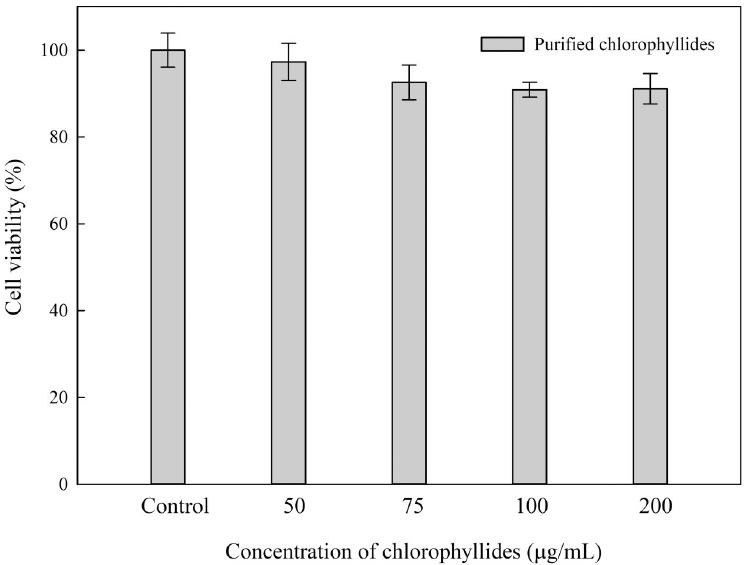
Fig 3. MTT assay of chlorophyllides in NIH/3T3 cells. The results showed that when the concentration was 200 μ g/ mL, there is no statistical difference between the control group (chlorophyllides absent). Data representing mean ± SE from five independent replicates was subjected to further statistical analysis by one way ANOVA using SigmaPlot Version 14.0. One-way ANOVA for this experiment returns p =